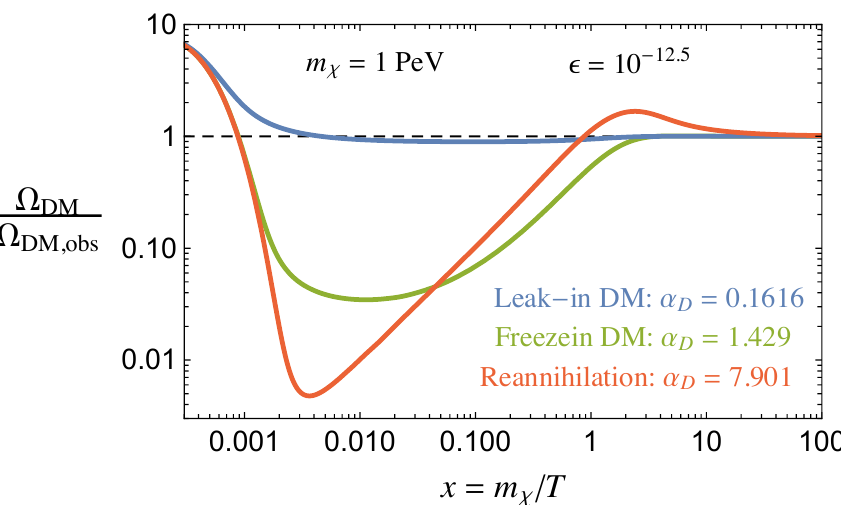
Figure 3. Evolution of the DM number density as a function of m (cid:31) =T for a point with three possible solutions for (cid:11) D . The smallest value of (cid:11) D (blue) corresponds to a dominantly leak-in solution (with a small contribution from freezein), the intermediate value of (cid:11) D (orange) gives a dominantly freezein solution (with a small contribution from leak-in), and the largest (cid:11) D (green) yields reannihilation. The parameters used for the (cid:12)gure were selected to emphasize the di(cid:11)erence between the three